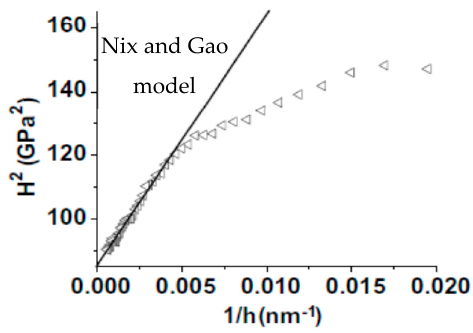
Figure 5. Indentation size effect in polished MgO: experimental results versus the Nix and Gao [13] model ( H 0 = 9.24 GPa; h ∗ = 92.5 nm ) (after Feng and Nix [98]).